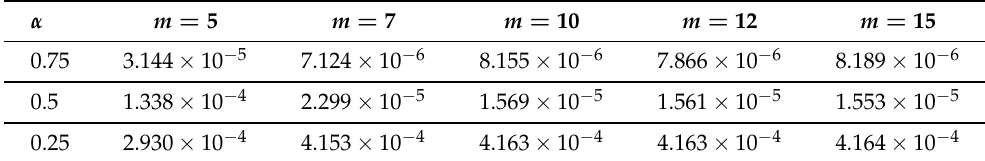
Table 3. The modified additive splitting algorithm: errors of the solution of the discrete scheme (28) and (29) for α = 0.75,0.5,0.25 and a sequence of parameters m